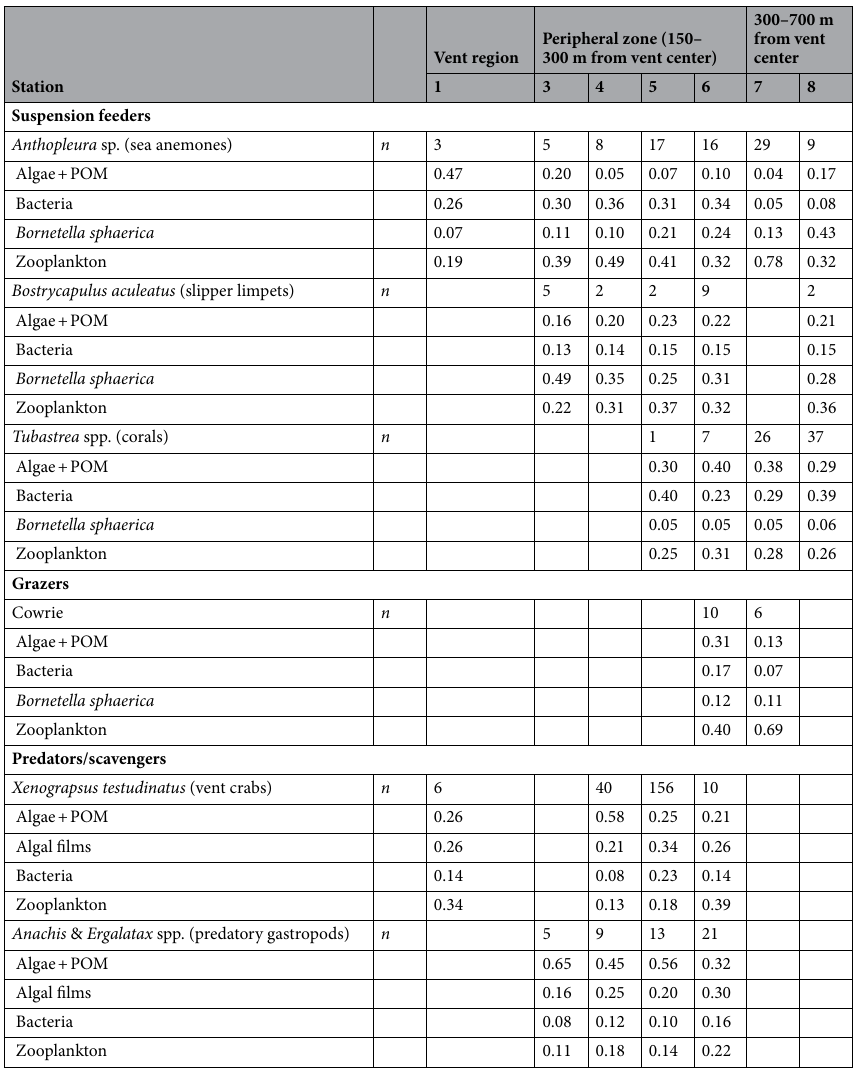
Table 3. Mean trophic contributions of basal resources to the benthic consumers collected from the Kueishan Island shallow-water vents, based on the Bayesian mixing models using MixSIAR. Contributions are on a scale from 0 (0%) to 1